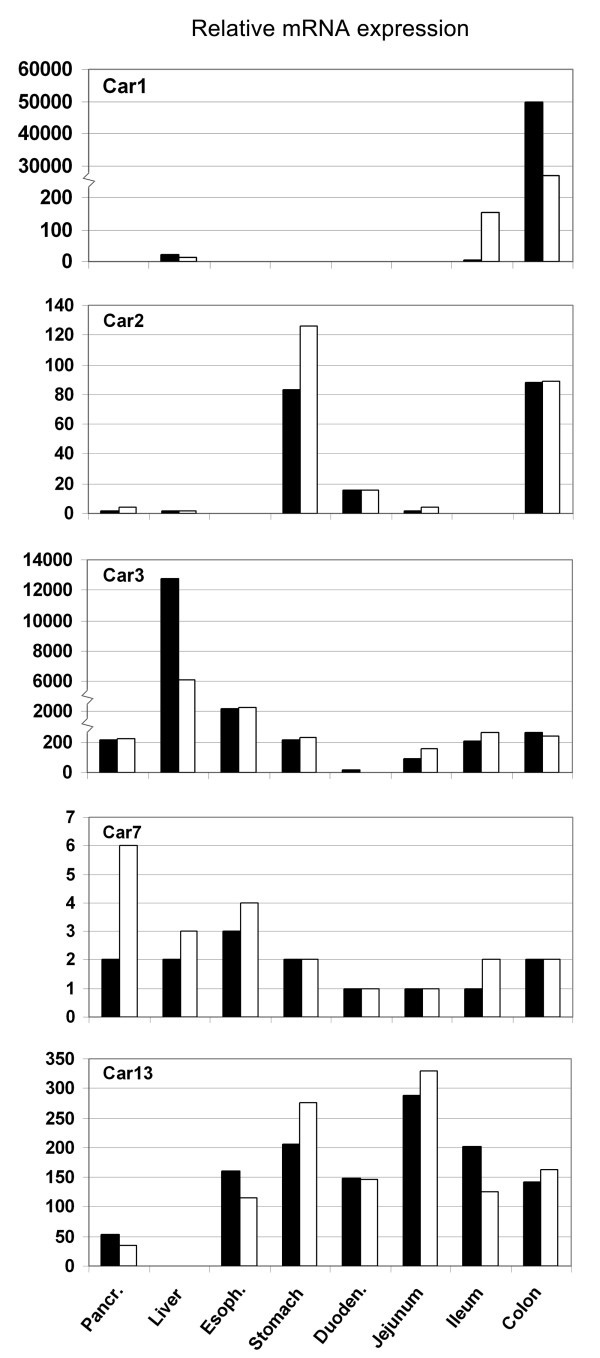
Expression of transcripts for cytosolic CAs. Solid and open bars represent results obtained from male and female mice, respectively.